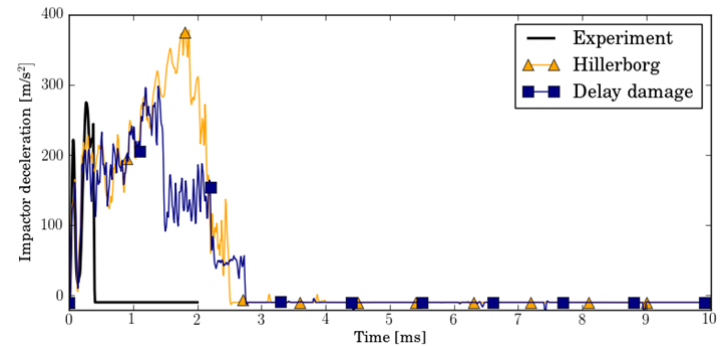
Fig. 15 Comparison of simulation results of glass with immediate failure model to experimental data for drop weight